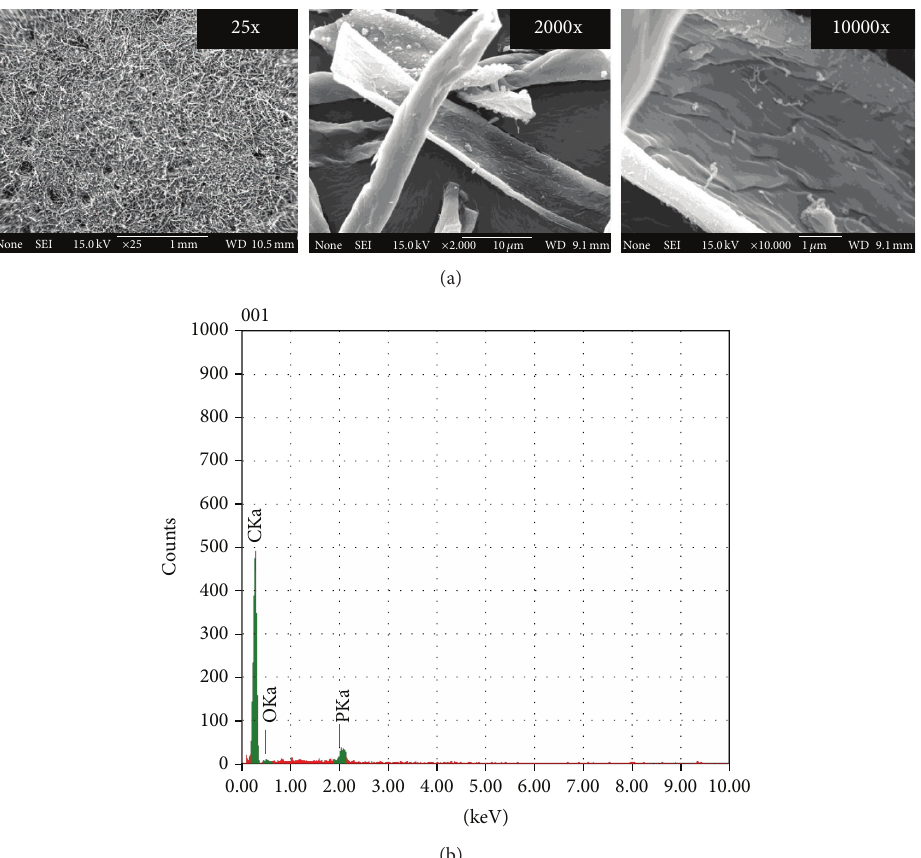
Figure 1: SEM macro- and microimages in three magnifying stages (25x, 2000x, and 10000x) (a) and EDS spectrum (b) of ACCF employed in the